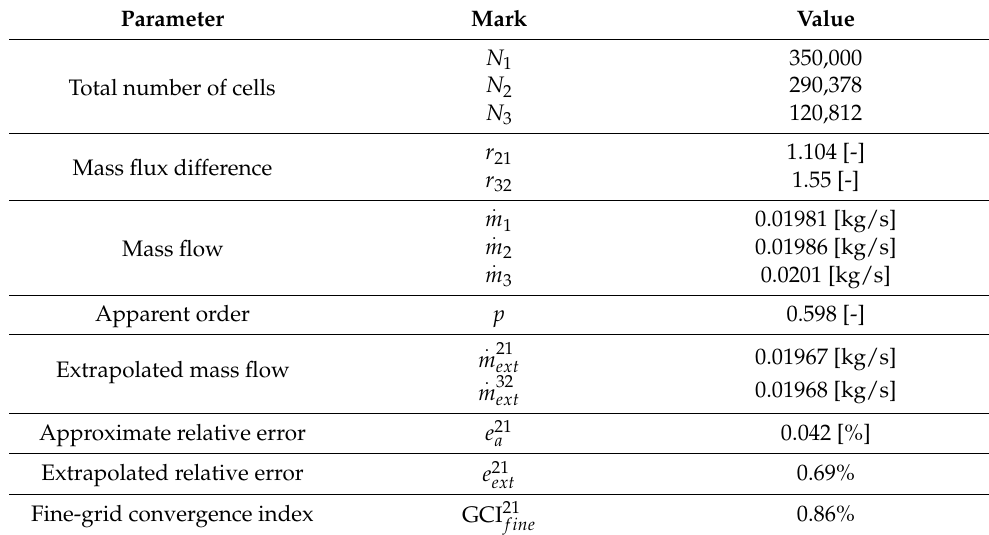
Table 2. Parameters used in the grid convergence method